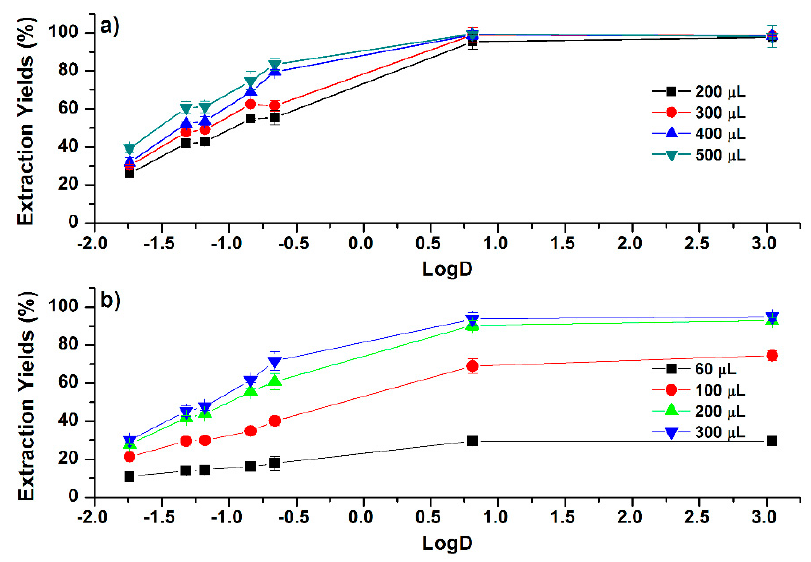
Figure 5. Correlations between EYs and the LogD (pH 7.4) values of phenolic compounds under different addition volumes of ( a ) dichloromethane (DCM) and ( b ) chloroform in ACN–H 2 O mixtures (50:50, v / v ). Error bars present the standard deviation ( n = 3).